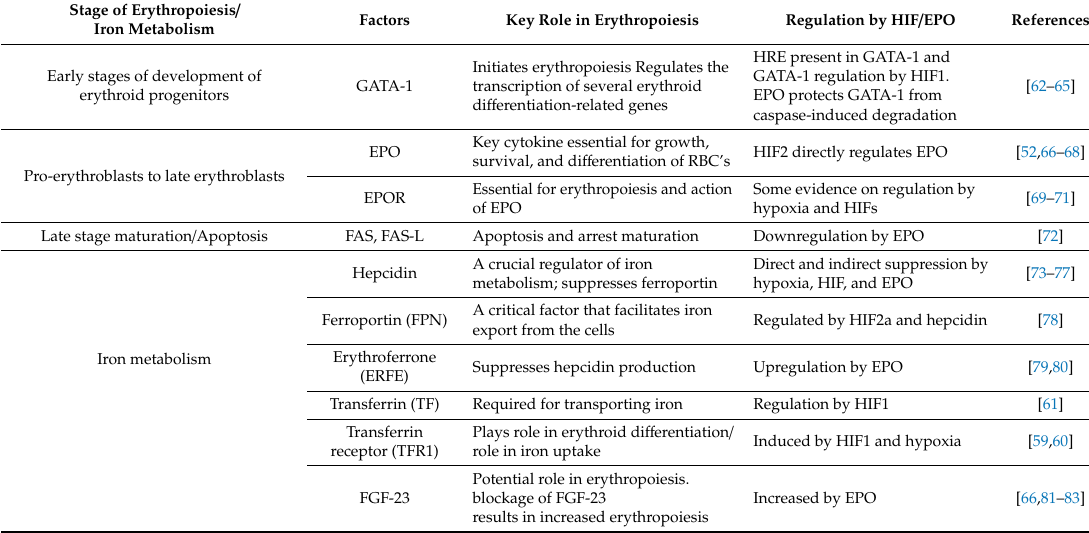
Table 1. Regulators of